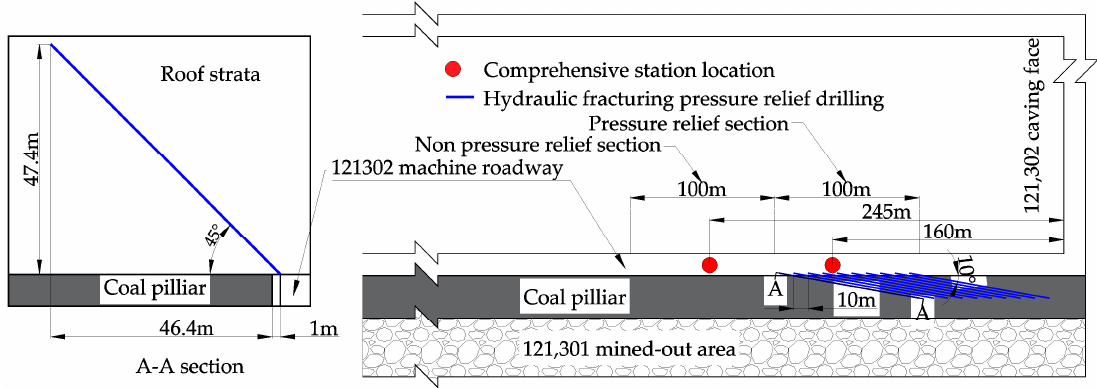
Figure 9. The pressure relief scheme and station layout.